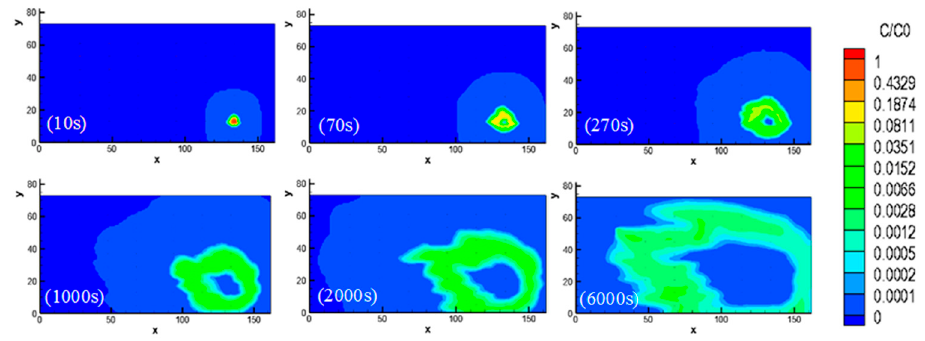
Figure 5. The positions of solute transport simulated at output time points of 10 s, 70 s, 270 s, 1000 s, 2000 s, and 6000 s under the reference K field in a group of pumping / injection tests. The units of axis are cm.